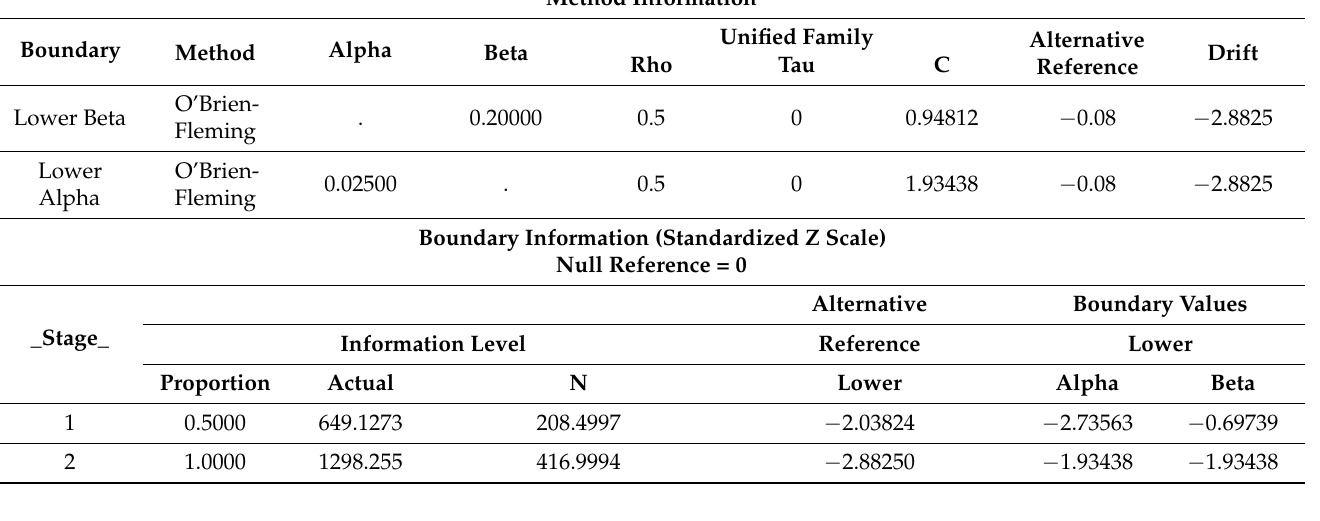
Table A3. Method Information of the SEQDESIGN Procedure.